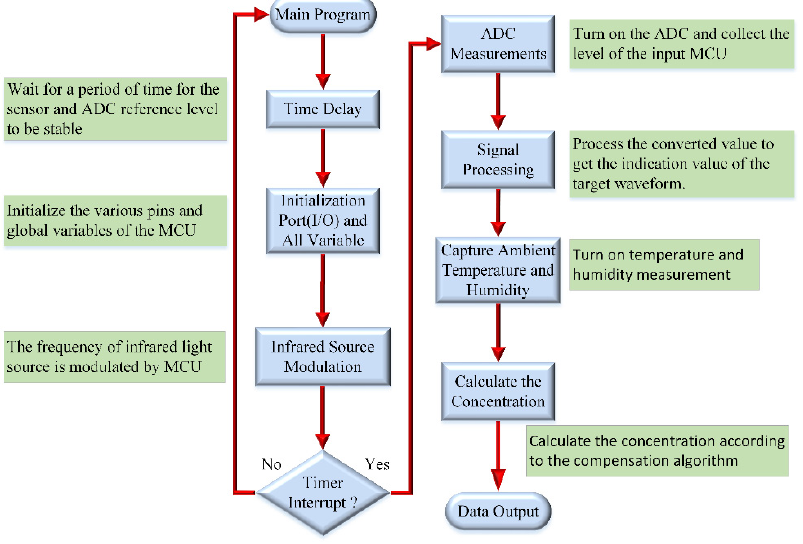
Figure 3. The system framework of the gas sensor module.